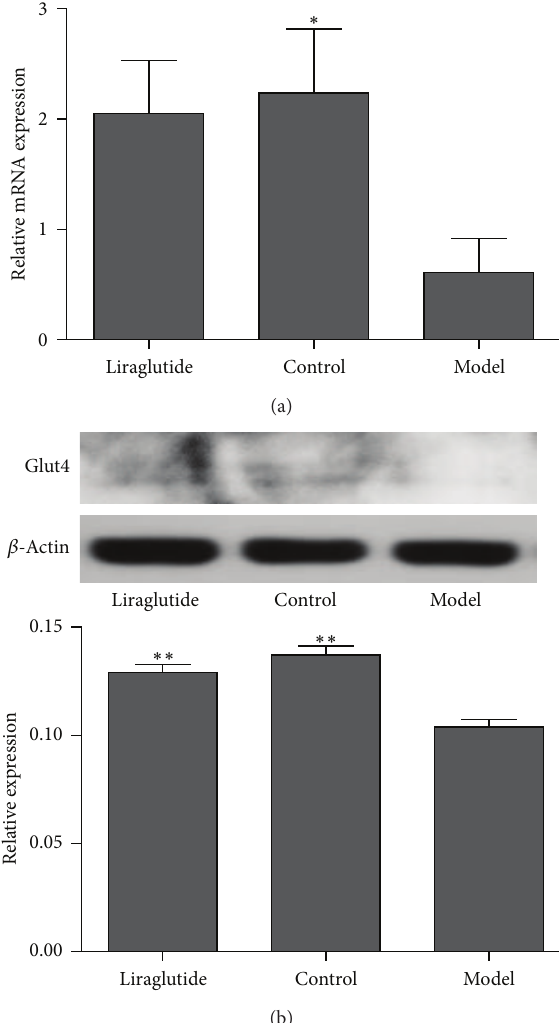
Figure 7: Effects of liraglutide on GLUT4 expression in skeletal muscle. (a) Expression in skeletal muscle of GLUT4 mRNA in nor- mal, model, or liraglutide group. Gene expression was measured by real-time PCR. Relative GLUT4 mRNA abundance was normalized by 𝛽 -actin. Data were shown as mean ± SEM, ∗ 𝑃 < 0.05 , ∗∗ 𝑃 < 0.01 versus model group, 𝑛 = 5 . (b) Expression of GLUT4 protein in skeletal muscle from normal, model, or liraglutide group. Lysates from freshly isolated skeletal muscle tissues were measured for GLUT4 expression by Western blot analysis. Results were shown as mean ± SEM, ∗ 𝑃 < 0.05 , ∗∗ 𝑃 < 0.01 versus model group, 𝑛 = 5